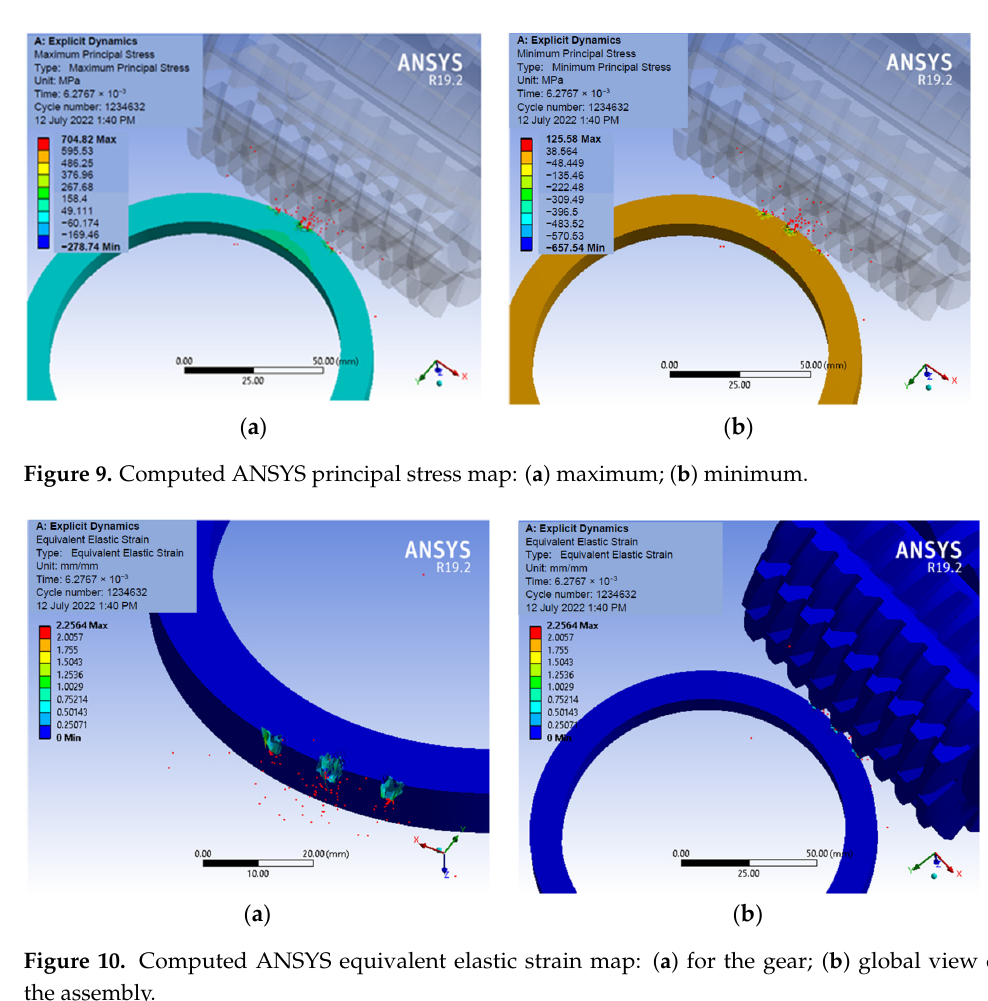
Figure 8. Computed ANSYS principal elastic strain map: ( a ) maximum; ( b ) minimum.